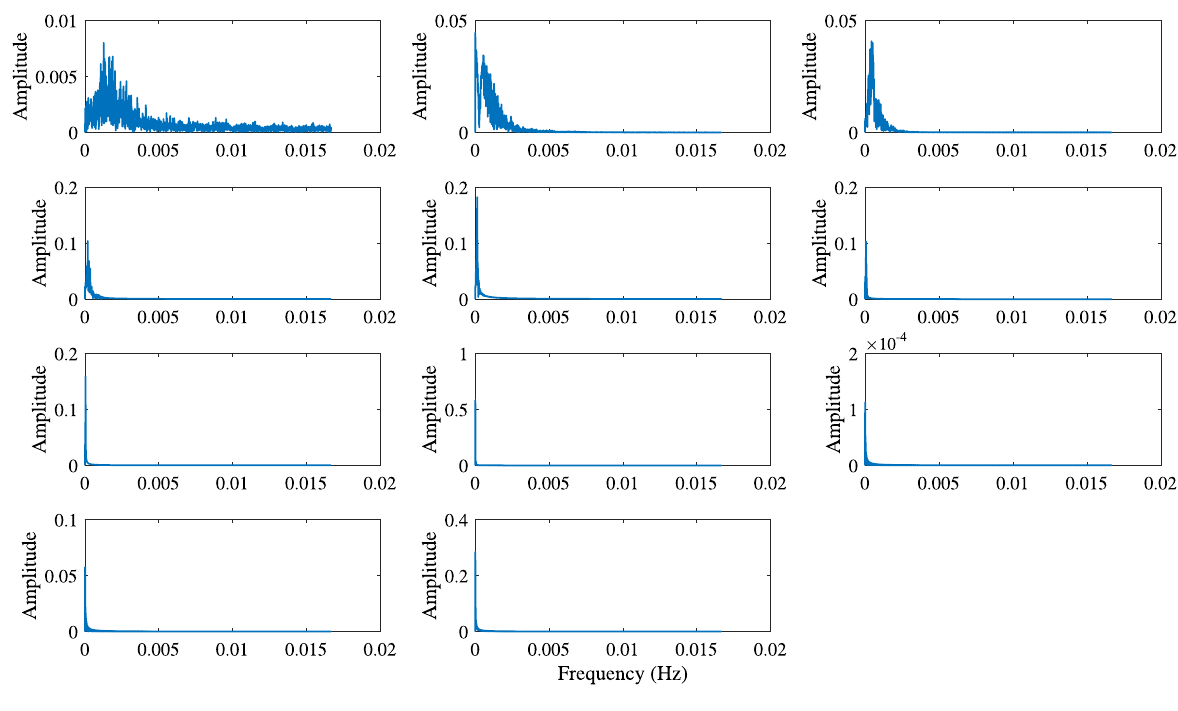
Figure 8. Frequencies of IMFs of EEMD of temperature at a depth of 155 m on July 29, 2018.